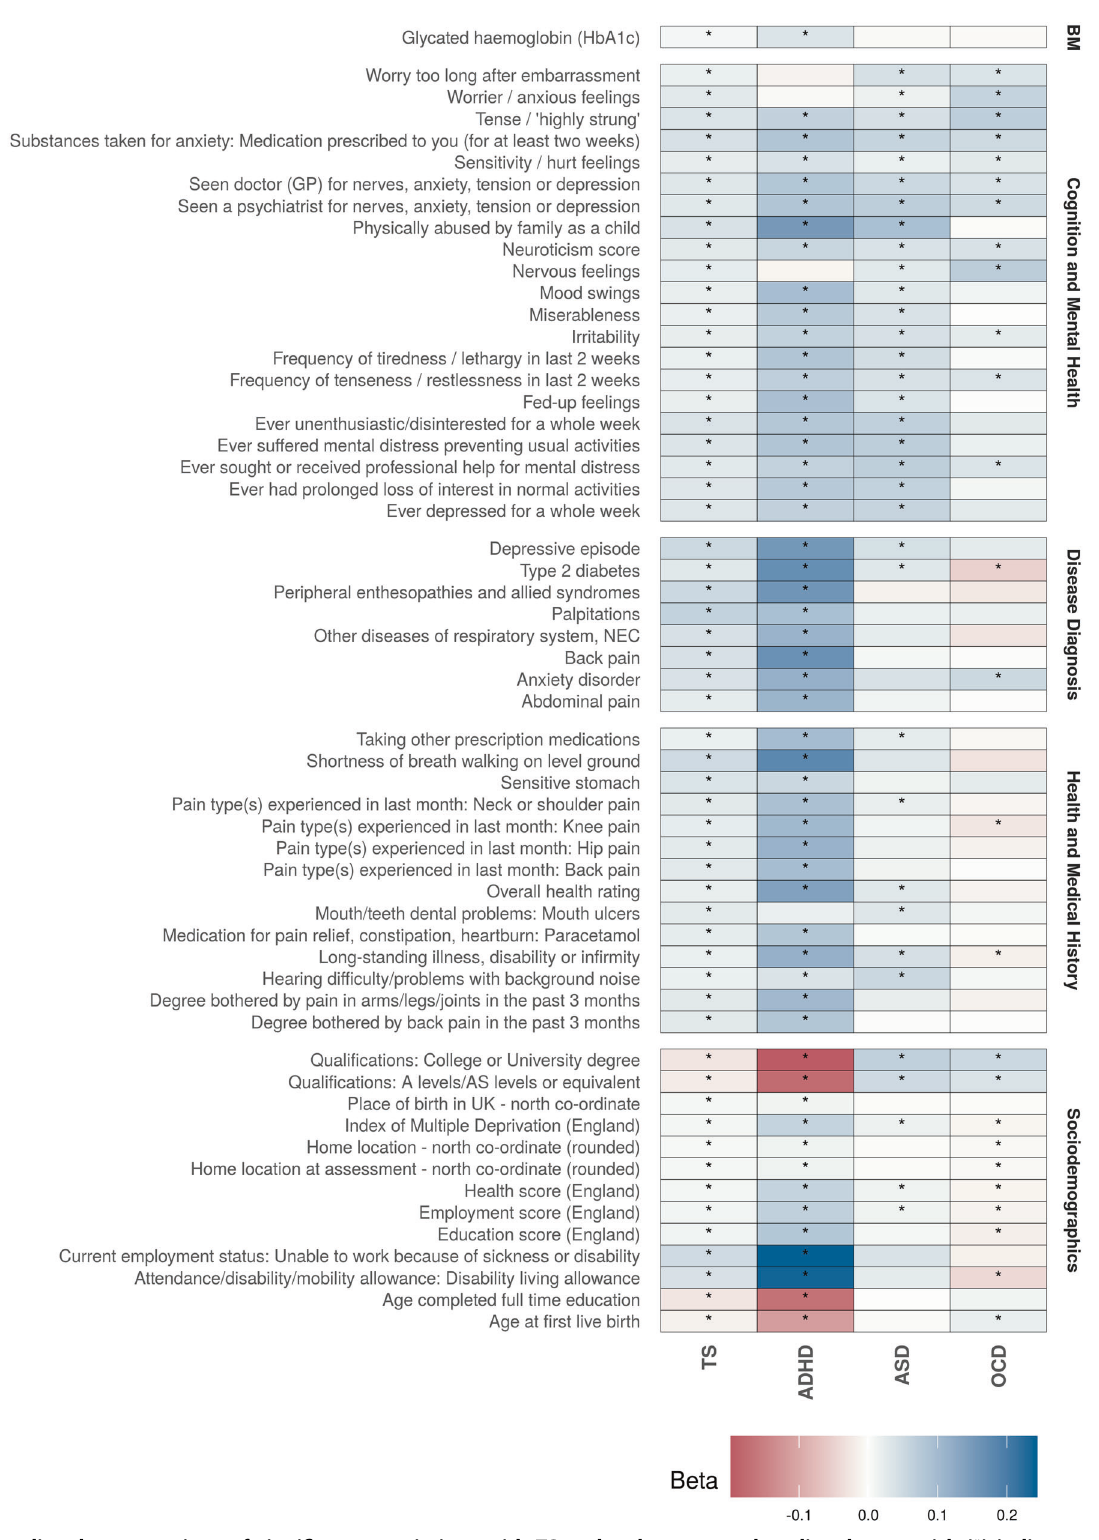
Fig. 4 Cross-disorder comparison of signi fi cant associations with TS and at least one other disorder; asterisk (*) indicates signi fi cant association after multiple testing correction. Each column indaicates the association between the phenotype and a disorder and the color represents the Beta (effect size) of association between the genetic risk of the disorder and the phenotypes. BM Biochemical